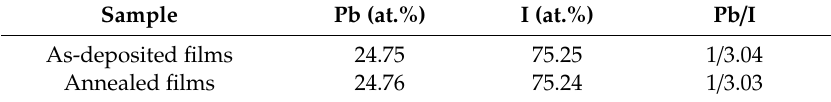
Table 1. The elemental ratio of Pb and I in as-prepared and solvent-annealed CH 3 NH 3 PbI 3 films measured by energy dispersive X-ray microanalysis system (EDS).